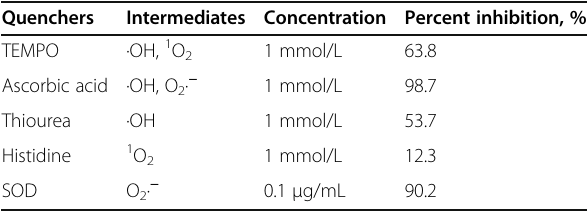
Table 1 Effects of various free-radical scavengers on the ABEI